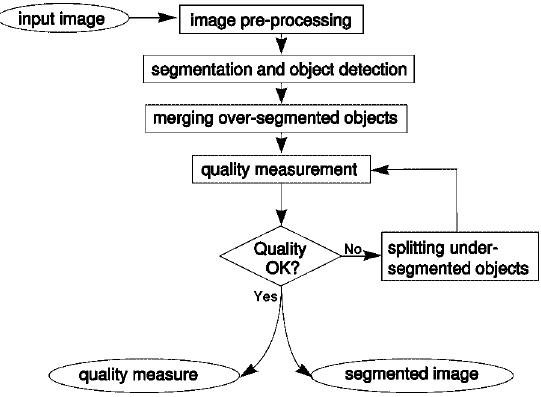
Fig. 1. An overview of the steps in the presented cytoplasm segmen- tation algorithm. Only objects that are considered not cell-like (ac- cording to the quality measurement) are sent to the splitting step. The different steps are explained in the